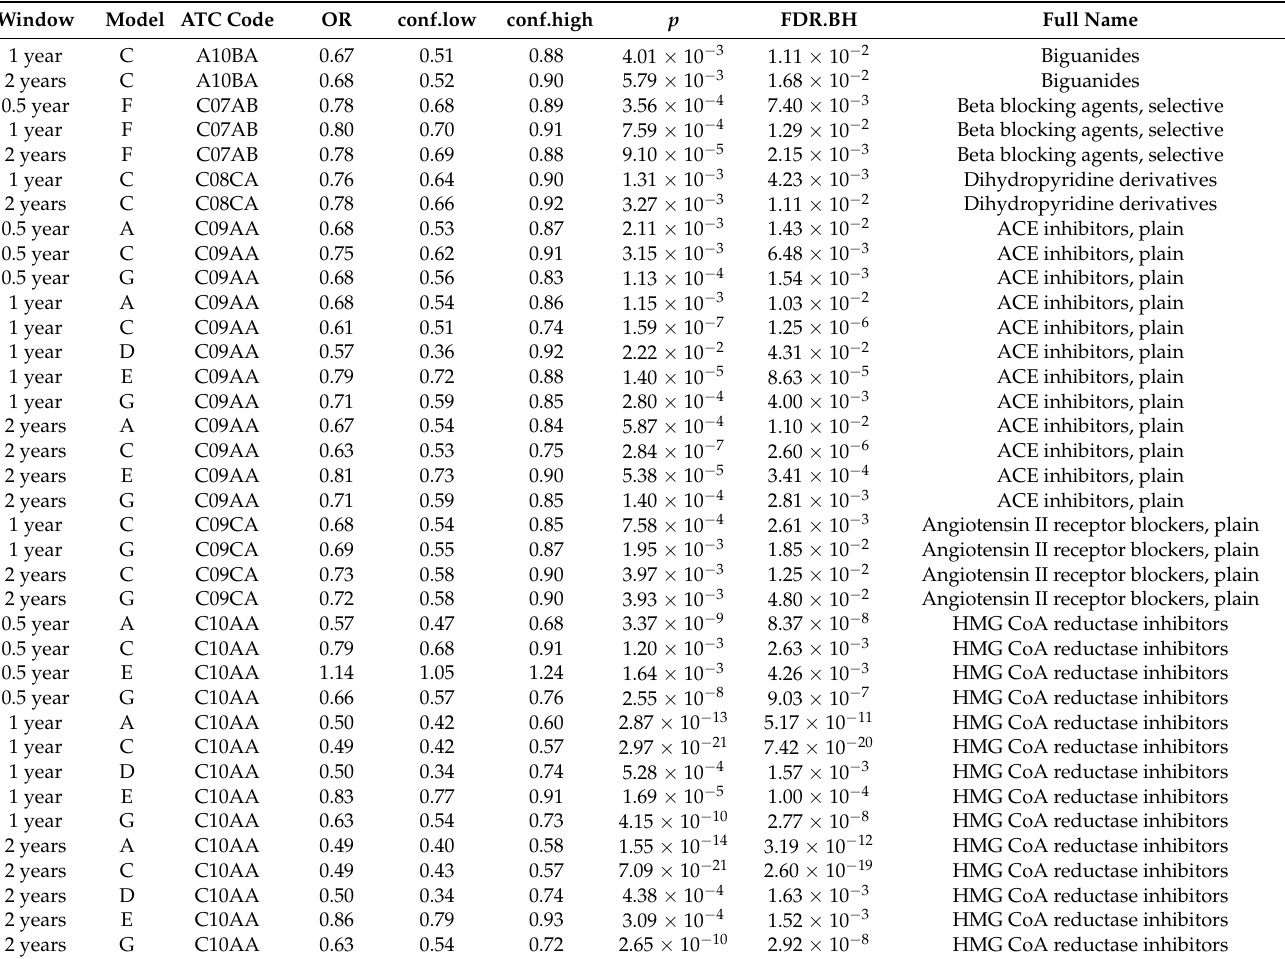
Table 3. Cardiometabolic medications showing significant protective associations (limited to FDR < 0.05) within time windows of 6, 12, and 24